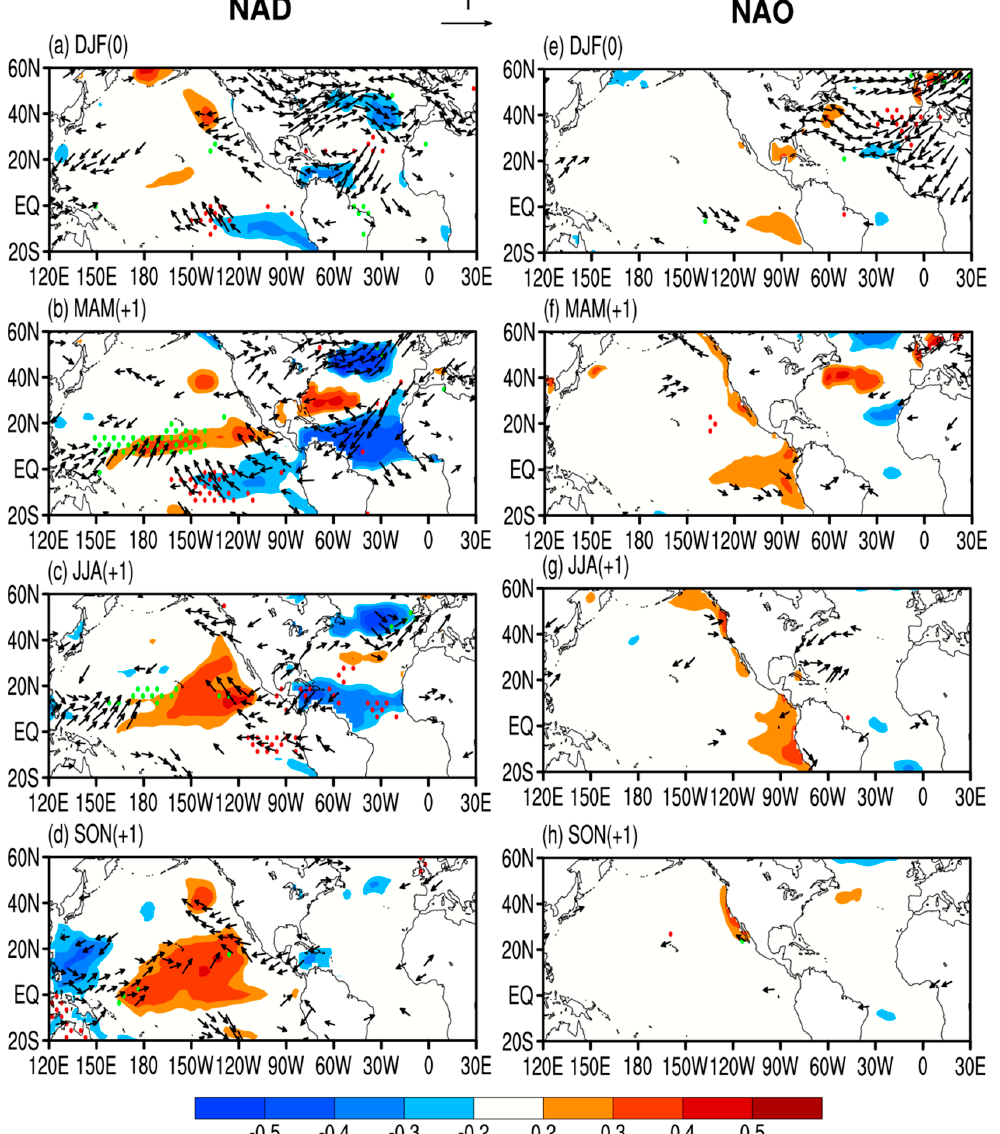
Figure 5. Partial correlation of the residual DJFM-averaged NADI with the SST (°C; shade), surface wind (vectors), and precipitation (stippled) anomalies for ( a – d ) DJF(0), MAM(+1), JJA(+1), and SON(+1), calculated by linearly removing the contemporaneous NAOI, and ( e – h ) those for the residual NAOI calculated by linearly removing the contemporaneous NADI. Positive (green) and negative (red) precipitation anomalies with correlations significant at or above 90% confidence level are stippled. Only surface wind vectors significant at or above the 90% confidence level are shown.